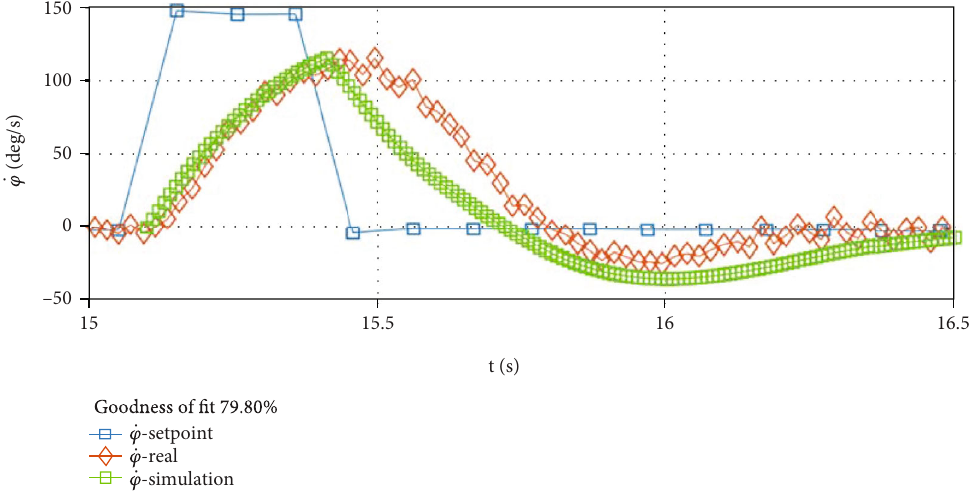
Figure 11: Yaw mode dynamic response comparison under a 0.3-s impulse